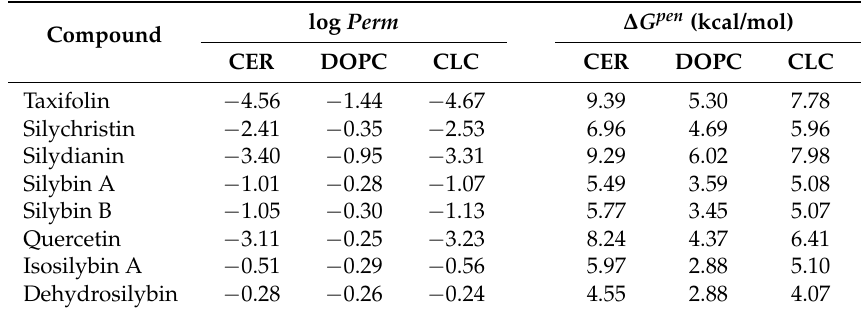
Figure 3. Free energy profiles of studied compound in ceramide (CER), dioleoylphosphatidylcholine (DOPC) and ceramide, lignoceric acid and cholesterol mixture (CLC) membrane models. Table 4. Permeability (log Perm ) and penetration barrier ( ∆ G pen ) calculated from COSMOmic free energy profiles in membrane models.